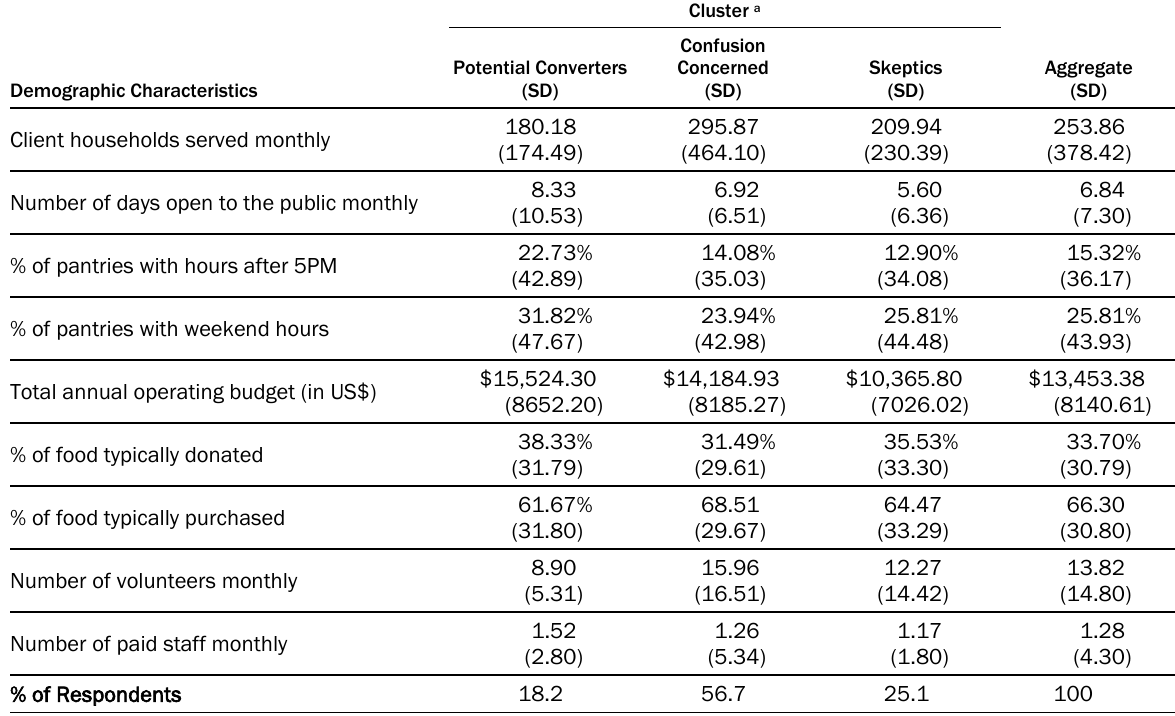
Table 3. Pantry Operating Characteristics, by Identified Cluster (n=187)